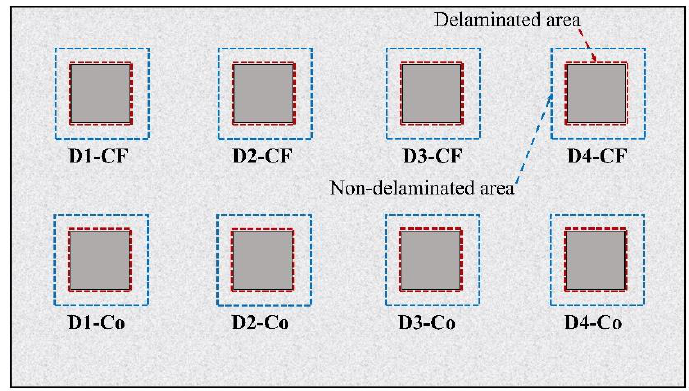
Figure 4. Selection of delaminated and non-delaminated areas.